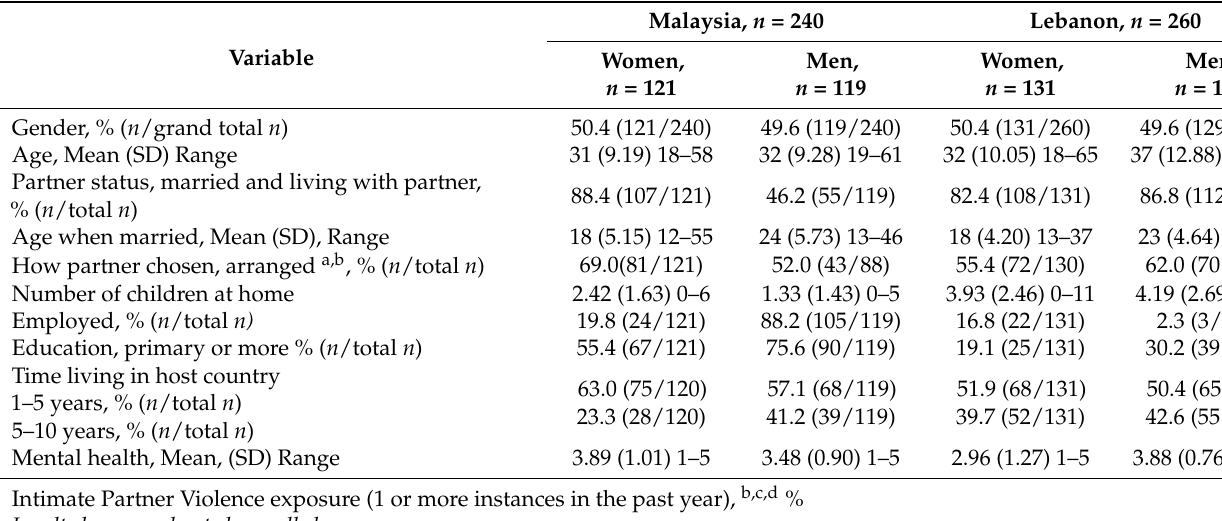
Table 5. Descriptive statistics, poster testing